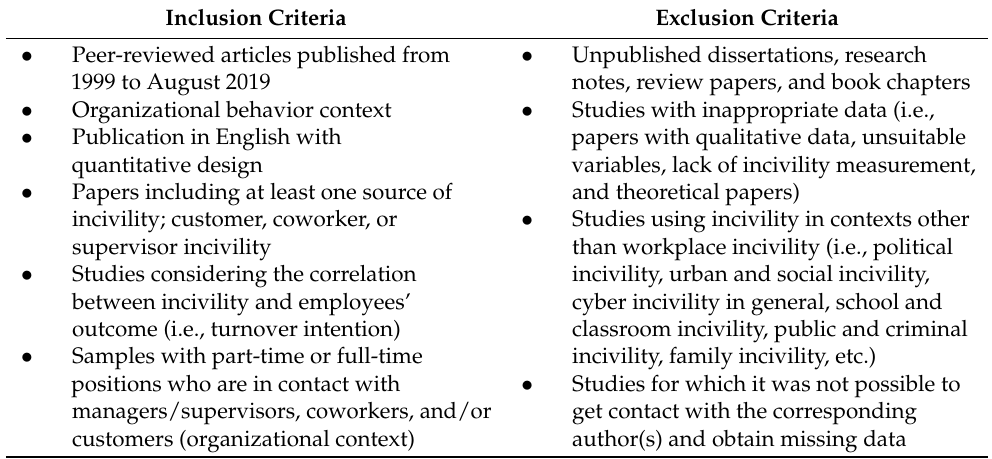
Table 1. Inclusion and exclusion